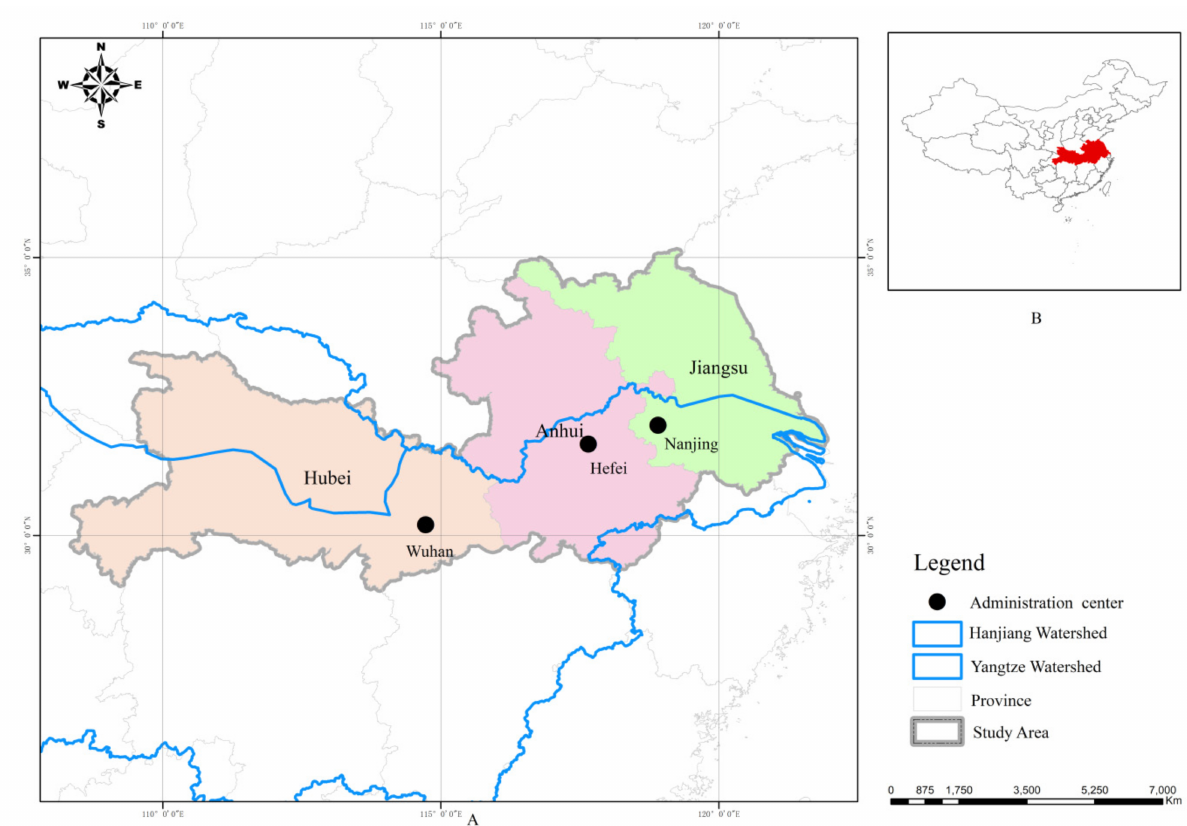
Figure 3. Map of study area: ( A ) Wuhan, Hefei, and Nanjing City; ( B ) the location of study area in